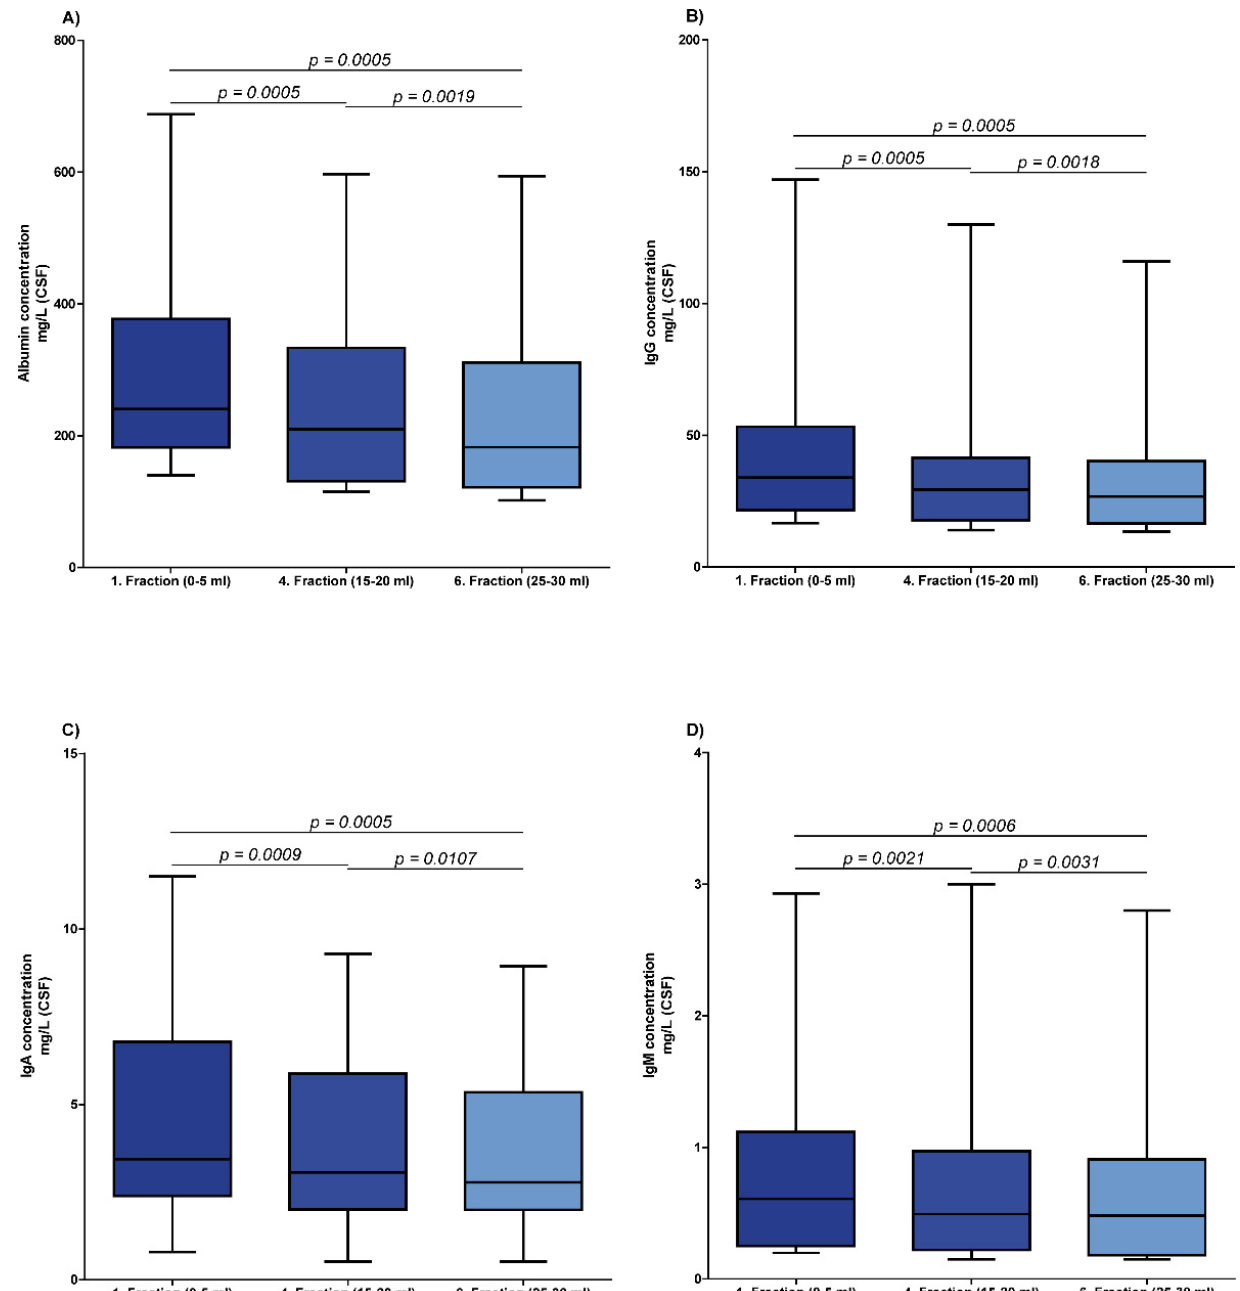
Figure 1. Cerebrospinal fluid (CSF) protein concentrations in different CSF fractions. Depicted are CSF concentrations of albumin ( A ), IgG ( B ), IgA ( C ) and IgM ( D ) of all included patients ( n = 16) suffering from normal pressure hydrocephalus (NPH) and idiopathic intracranial hypertension (IIH) in three different CSF fractions. A p- value indicating the level of statistical significance is de- picted above the line.